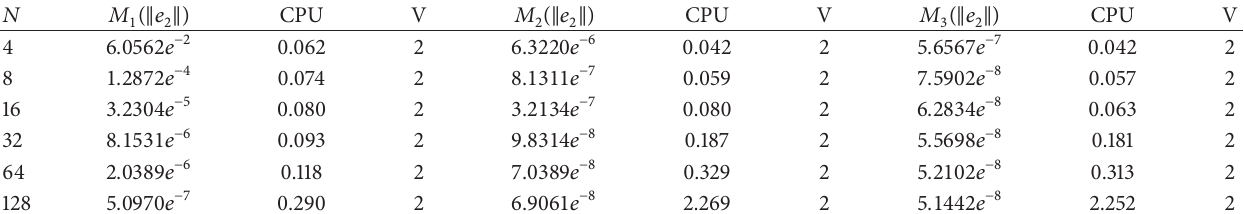
Table 2: Comparison of maximum absolute errors and CPU (seconds) for a Multigrid method with different schemes, for Example 2, ‖𝑒 2 ‖ , ℓ = 100 , and 𝑁 = 4, 8, 16, 32, 64, 128 .